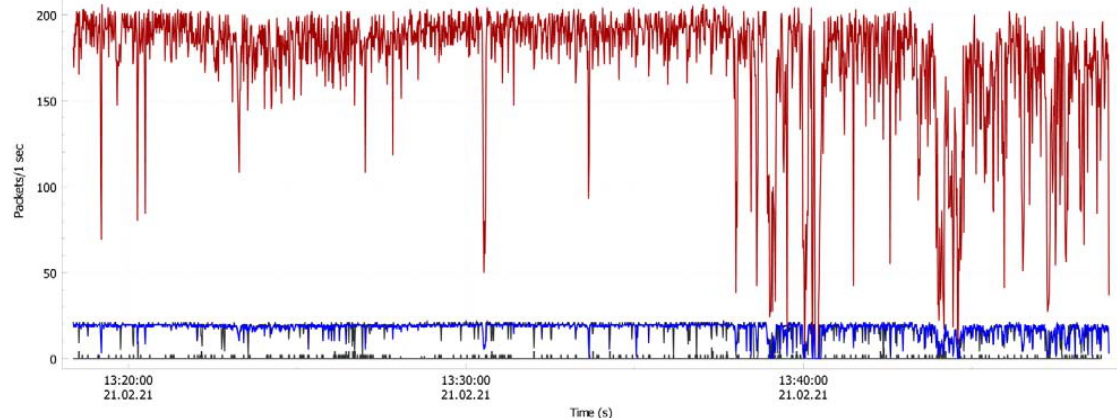
Figure 9. Traffic load in scenario 4 in packets per second in communication between the server and ten sensor nodes. The traffic load for the same scenario is shown in Figure 10. Figure shows the number of MQTT packets sent to the server, MQTT packets sent from single sensor node, and TCP errors per minute. The higher values (red line) represent MQTT packets sent to server, lower values (blue line) represent MQTT packets sent from individual node, and the lowest values (dark line close to the 0) present error packets per minute.